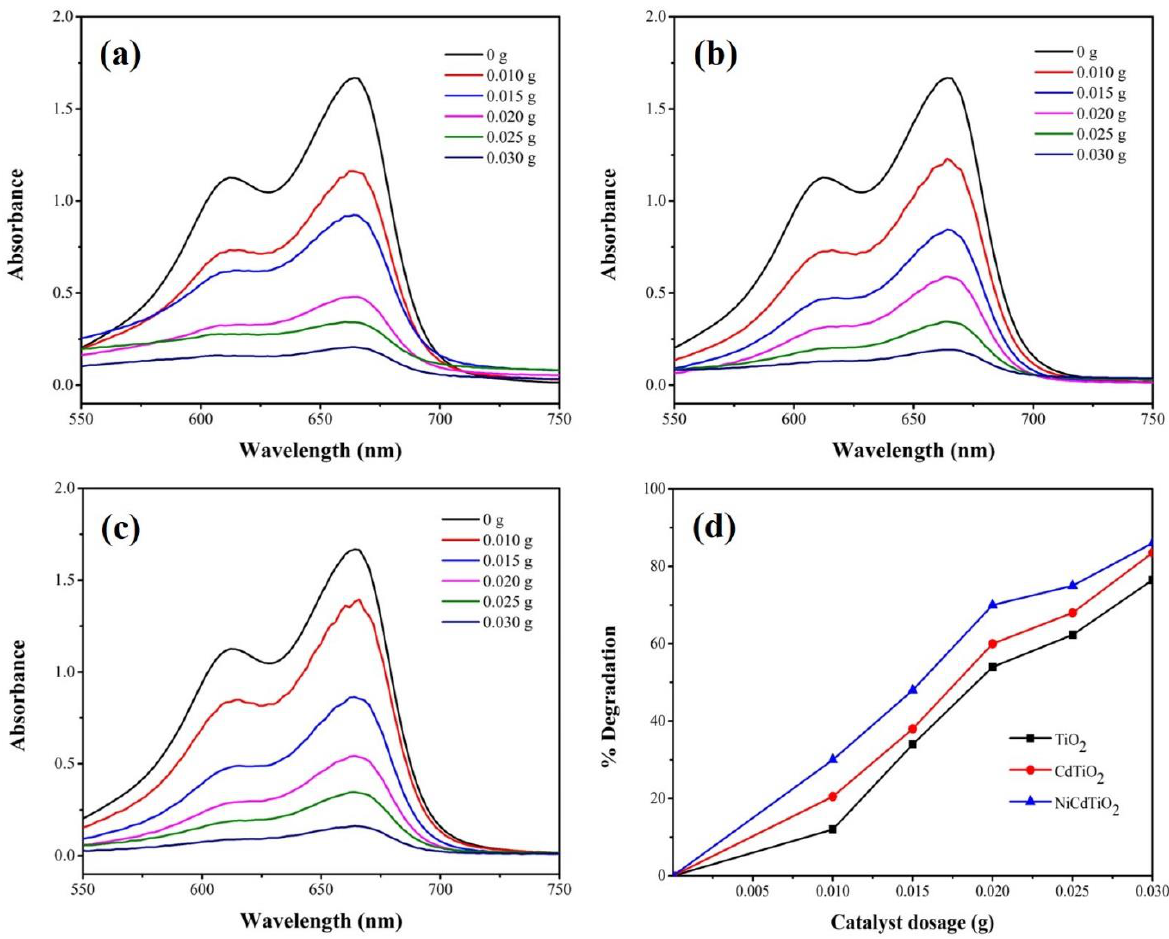
Figure 12. UV-VIS absorption spectra of MB dye before and after different dosage of ( a ) TiO 2 ( b ) CdTiO 2 ( c ) NiCdTiO 2 ( d ) Comparison of %degradation of MB dye photodegraded by different dosage of photocatalysts.